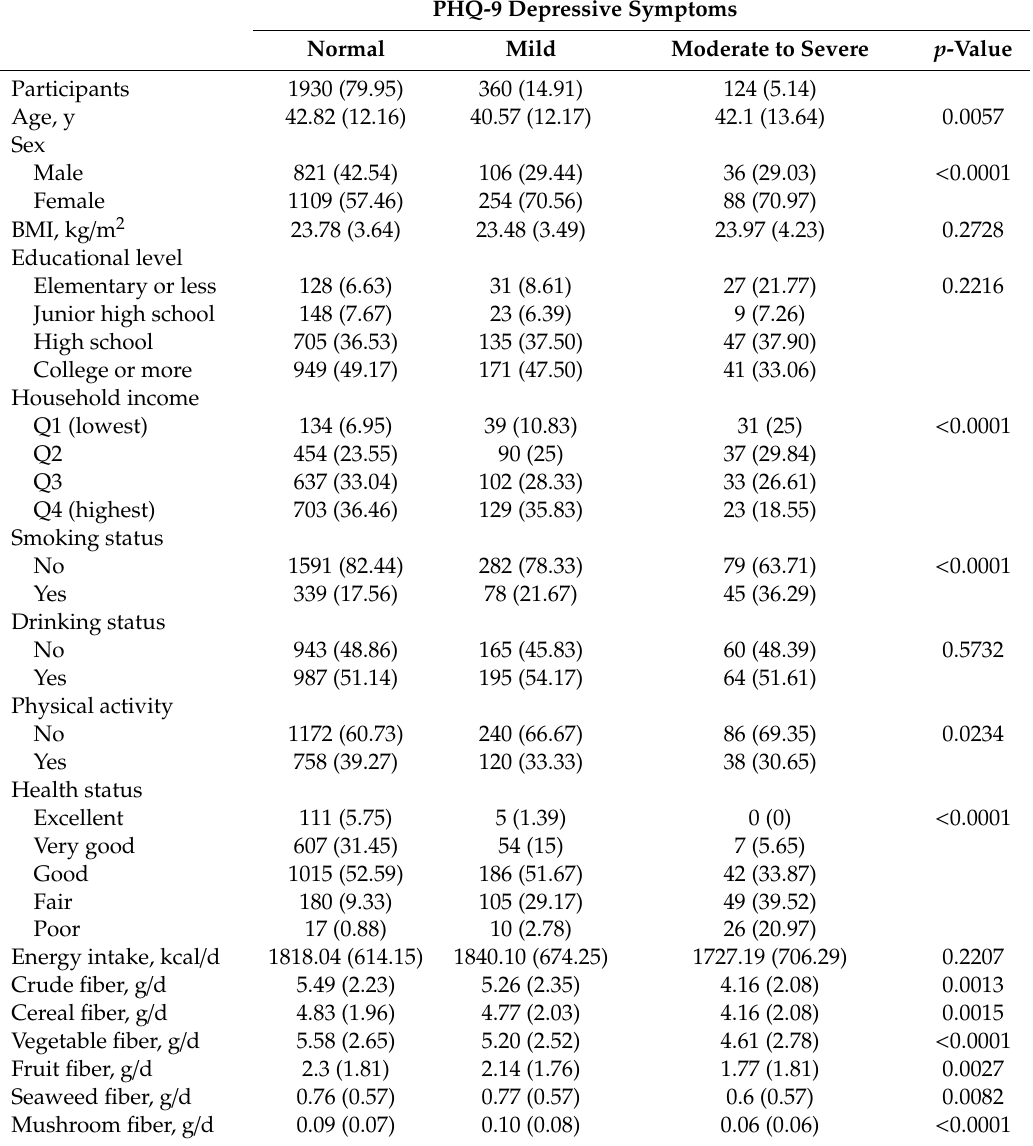
Table 1. General characteristics